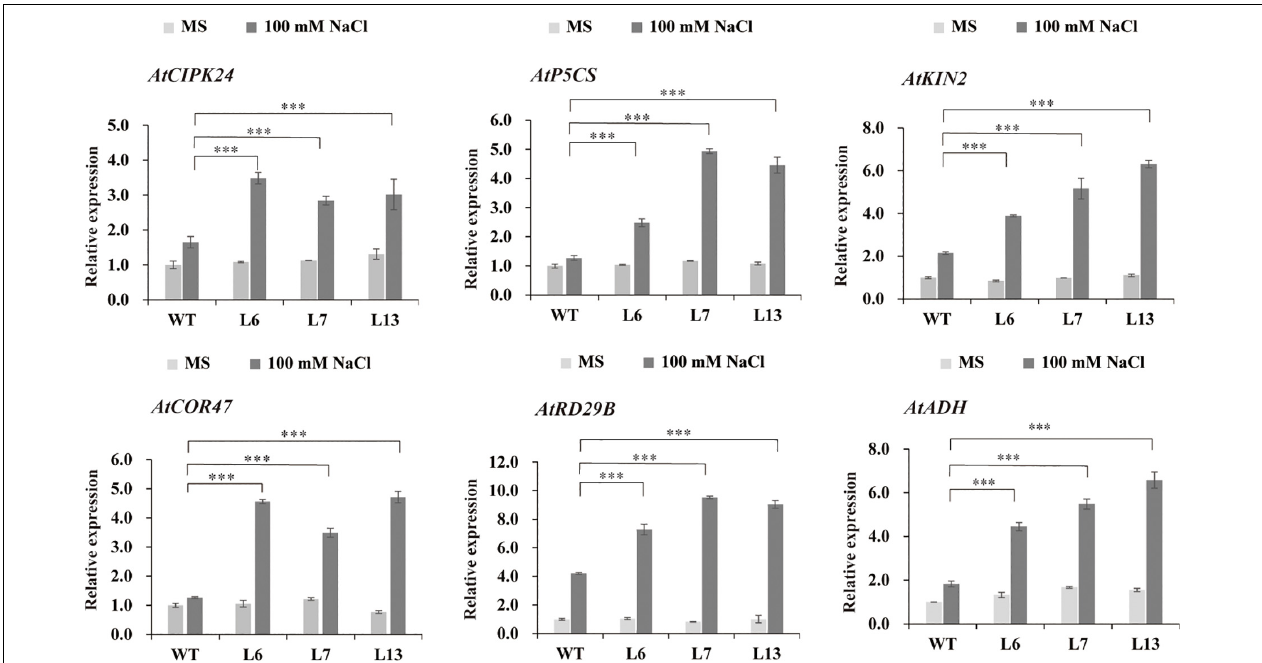
FIGURE 6 | Expression profiles of the six salt stress-responsive genes in WT and HbERF6 -overexpressing seedlings before and after salt stress using qRT-PCR. The seedlings were grown on MS agar plates for 11 days, and then transferred to MS medium or containing 100 mM NaCl for 10 days. Gene expression was quantified by RT-qPCR and analyzed using the 2 – (cid:49)(cid:49) CT method. AtACTIN1 was used as an inter-reference gene. The experiments were repeated three times. Asterisks show that the difference in the values is significant between the transgenic lines and WT at the same time point ( ∗∗∗ P <